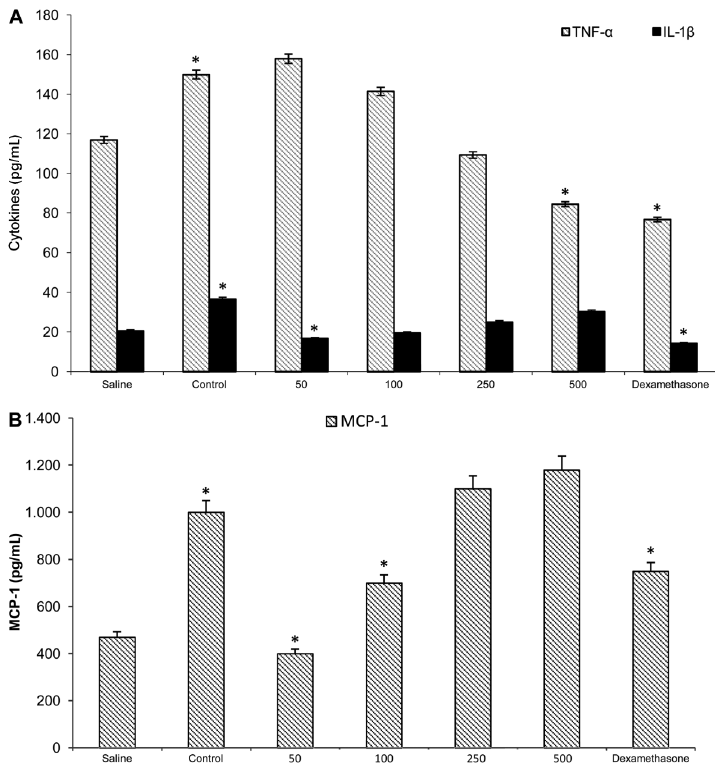
Figure 3. Effects of oral pretreatment with the hydroethanolic extract of Gochnatia pulchra (HEGP; 50, 100, 250, and 500 mg/kg) or dexa- methasone (10 mg/kg) on carrageenan-induced TNF- a and IL-1 b ( A ) and MCP-1 ( B ) production. Data are reported as means ± SE of 6 animals. In the control, carrageenan stimulation increased neutrophil secretion in the supernatant after 4 h. *P o 0.05, compared to the saline control (one-way